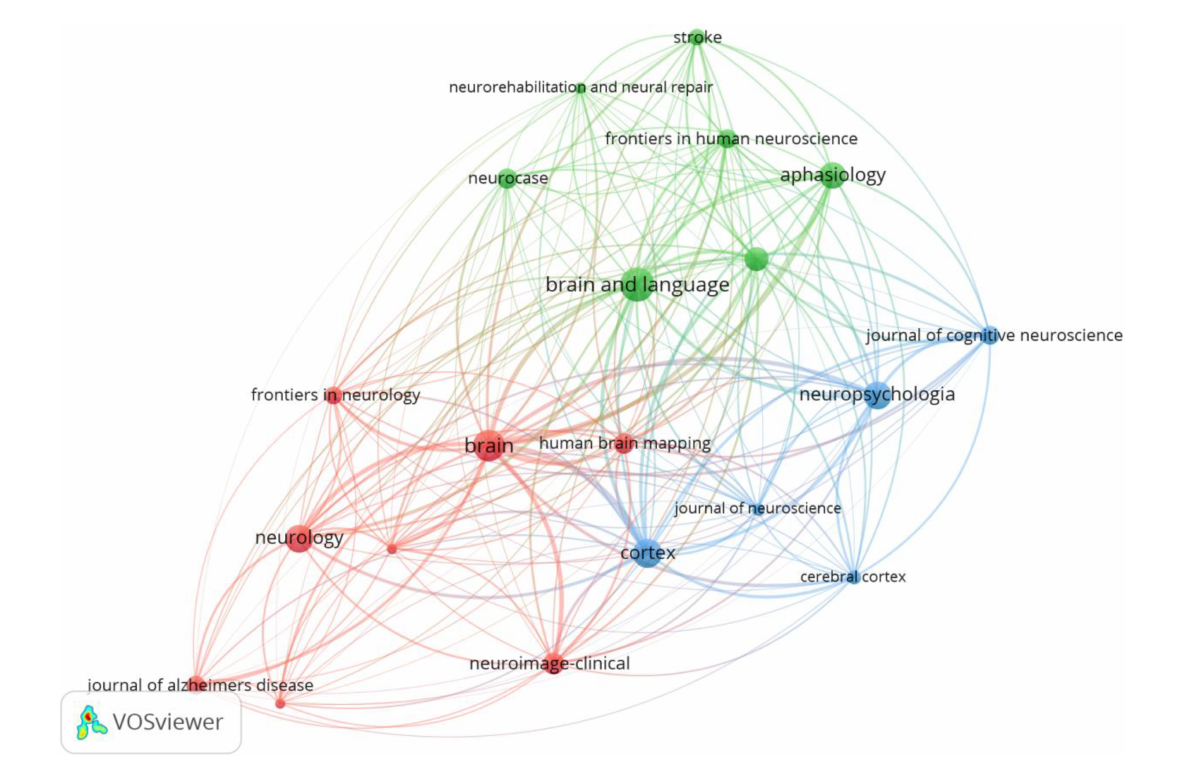
FIGURE4 Journals network map of neuroimaging research on aphasia. Nodes represent journals and larger nodes represent more publications. Clusters are represented by different colors, and links represent co-citation relationships between journals.